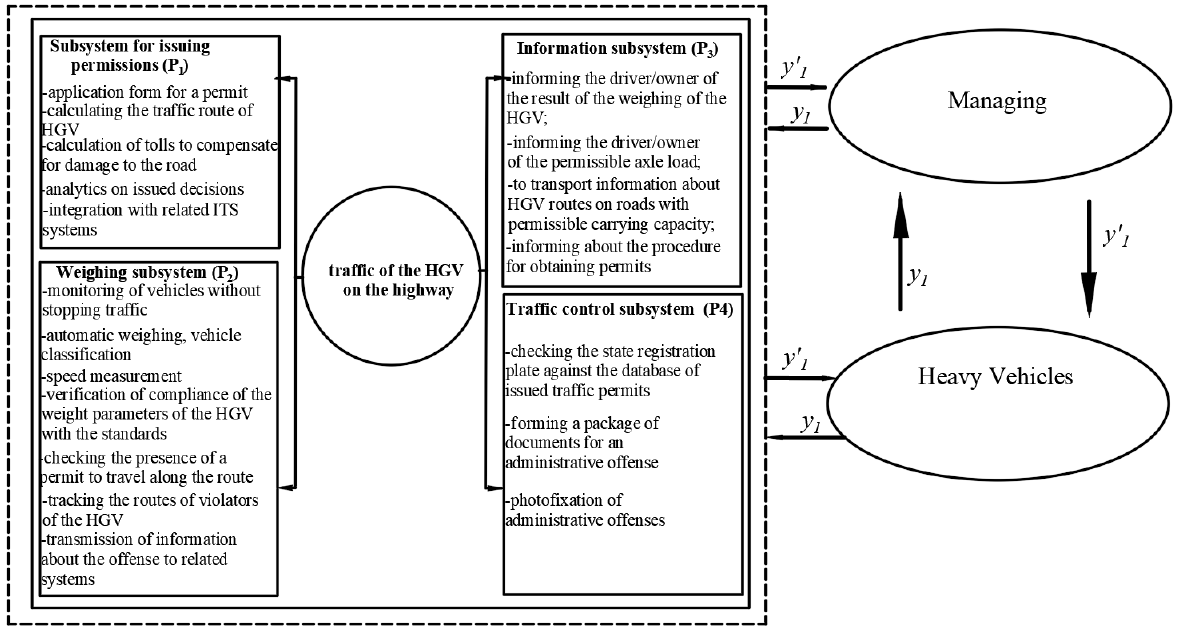
Figure 2. Model of the functional subsystems of the TASWC HGV.